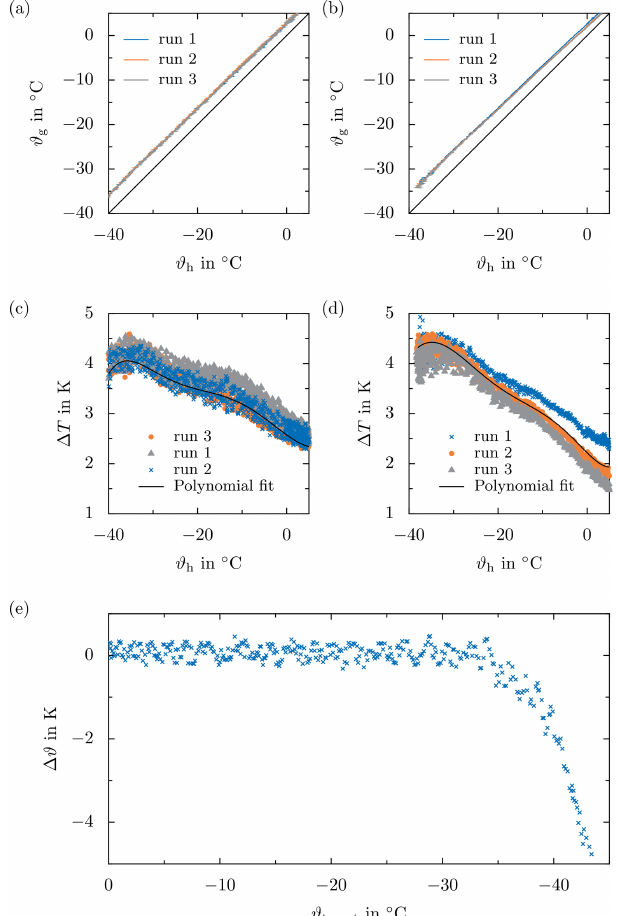
Figure 8. Example data obtained during temperature calibration. (a, b) Sapphire substrate temperature ϑ g as a function of the ceramic temperature ϑ h for ˙ T = 3Kmin − 1 and ˙ T = 5Kmin − 1 . (c) Differ- ence between the sapphire substrate temperature ϑ g and the ceramic temperature ϑ h depending on the latter for ˙ T = 3Kmin − 1 and ˙ T = 5Kmin − 1 . (e) Test of the temperature calibration ˙ T = 5Kmin − 1 : difference between the indirectly measured sapphire substrate tem- perature and the target temperature ϑ target prescribed by the Peltier controller in order to follow the temperature ramp, depending on the target temperature